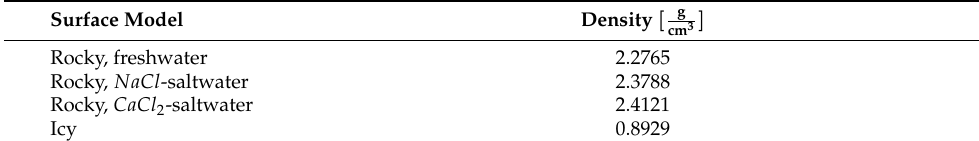
Table 2. Surface densities.